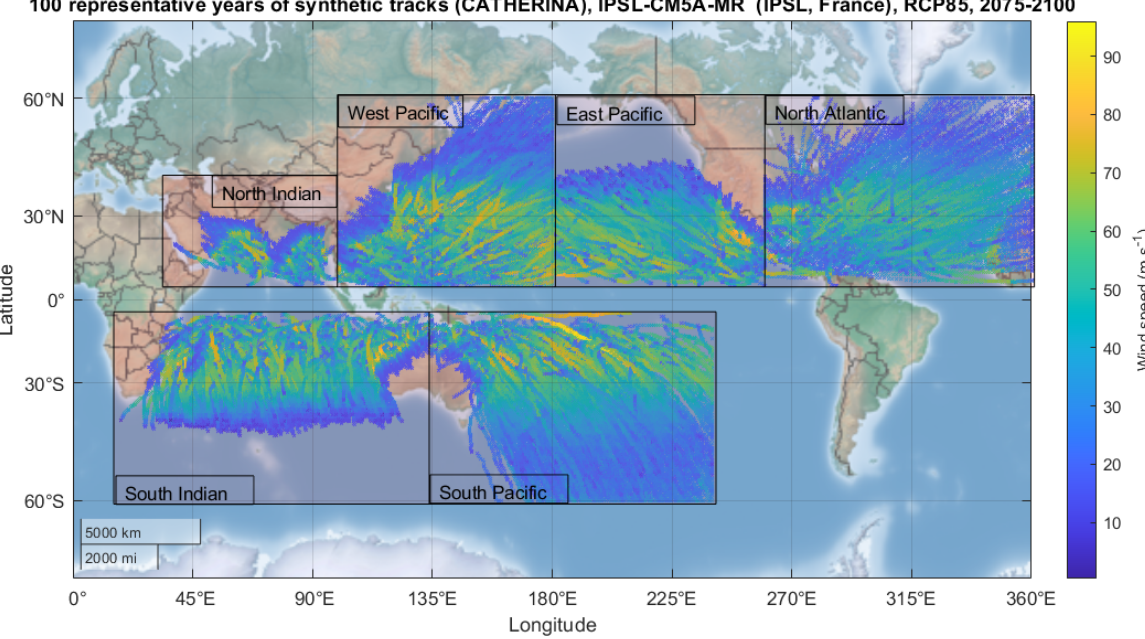
Figure 11. Example of 100 representative years of synthetic tracks produced with CATHERINA on IPSL-CM5A-MR raw climate data in RCP85 between 2075 and 2100 (i.e., four runs over the 25-year